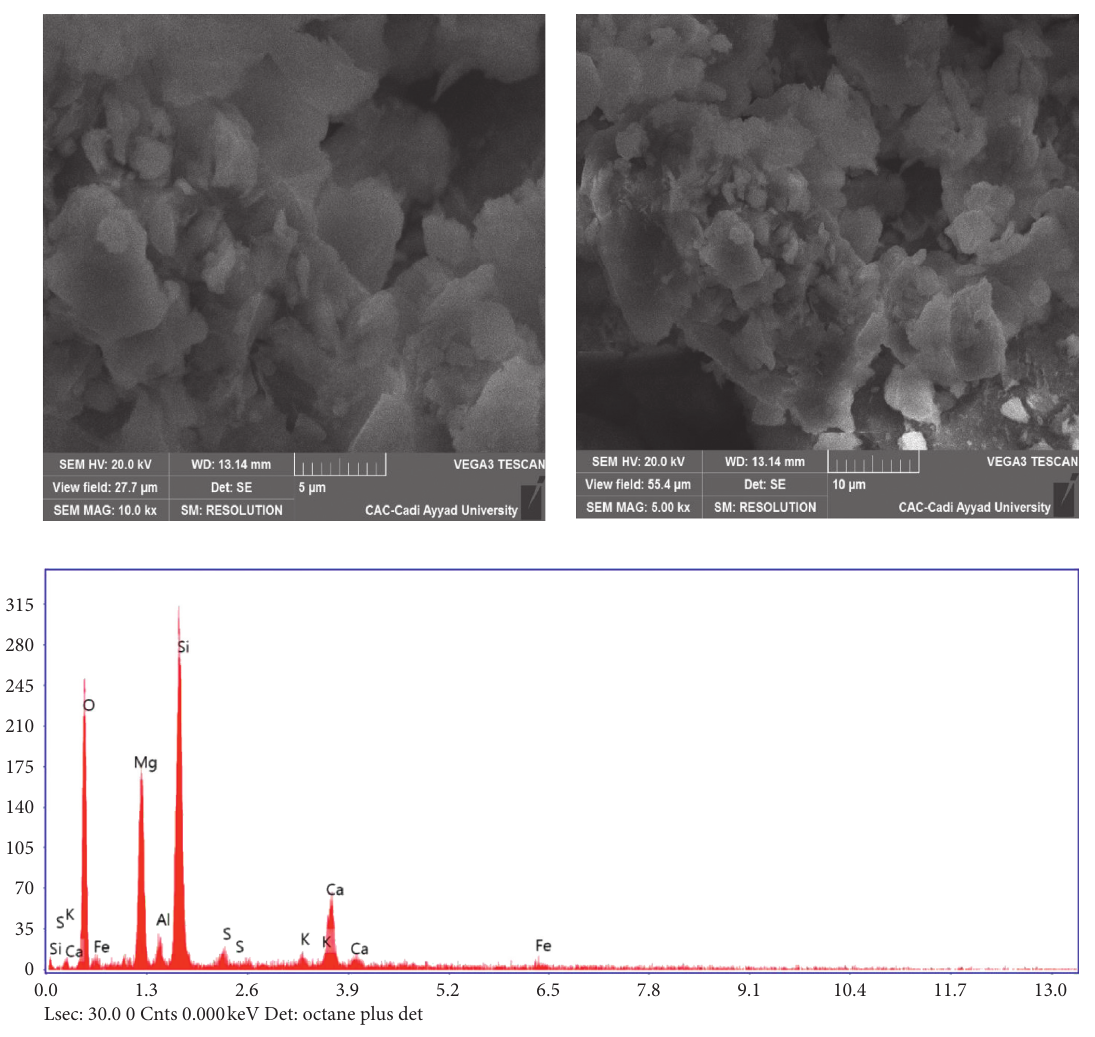
Figure 4: SEM images and EDX analysis of Gh-B. Table 2: Chemical elements of Gh-B and their